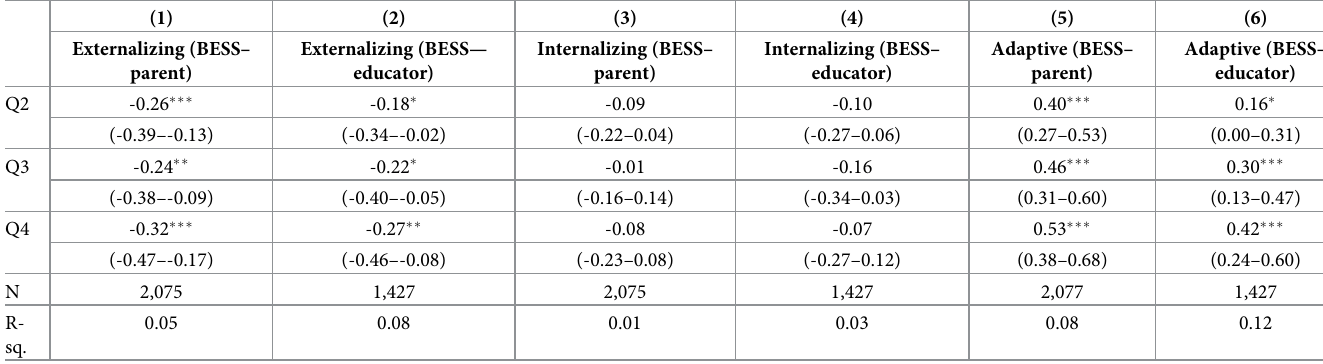
Table 5. Average SES effects in behaviors.